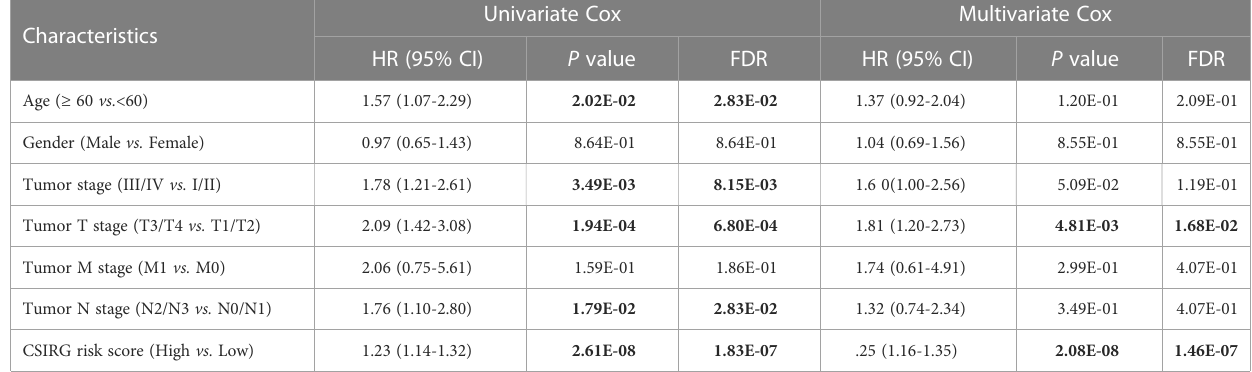
TABLE 2 Univariate and multivariate Cox regression to analysis independent prognosis factors in the TCGA-SKCM cohort.